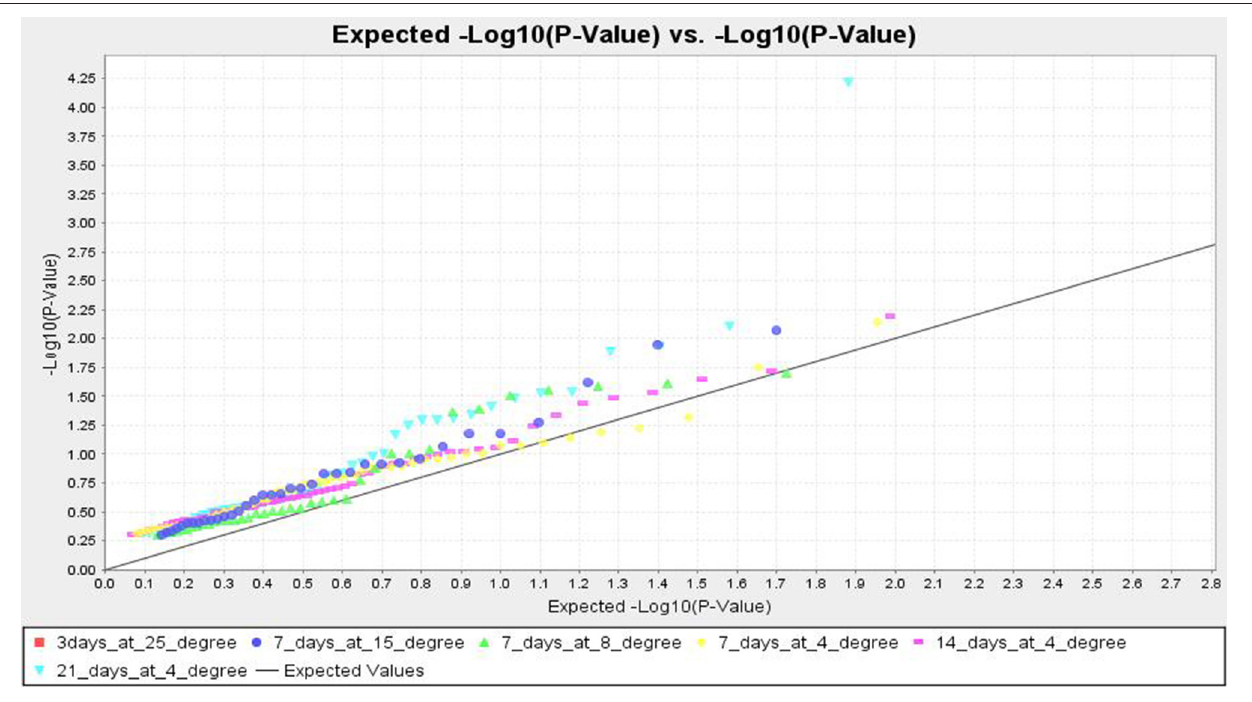
FIGURE 7 | Quantile–Quantile (QQ) plot and distribution of marker-trait association from MLM analysis at different low temperature regimes.